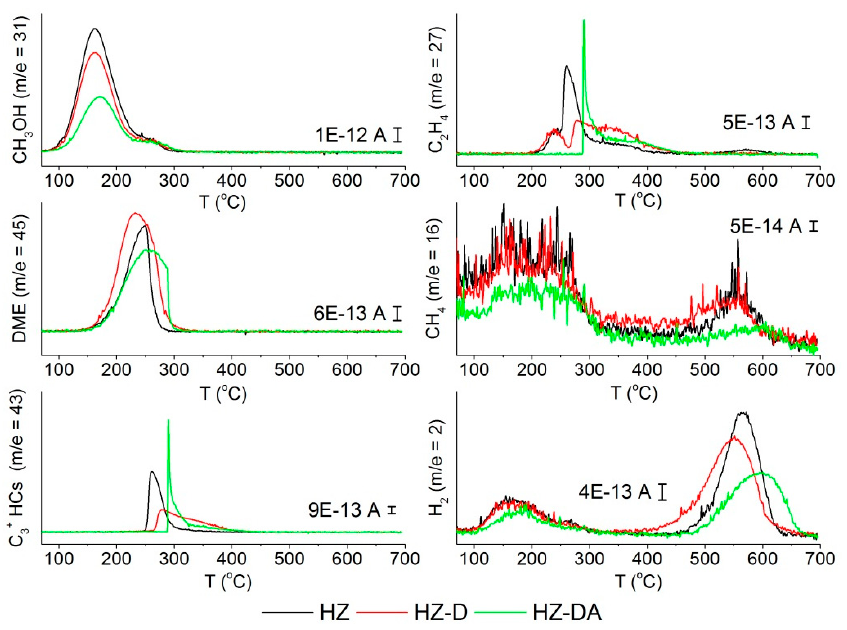
Figure 7. MS spectra of methanol, dimethyl ether, C 3+ hydrocarbons, ethylene, methane, and hydrogen of TPD of methanol. Reaction conditions: The He stream of 50 mL/min and the heating rate of 20 °C/min.